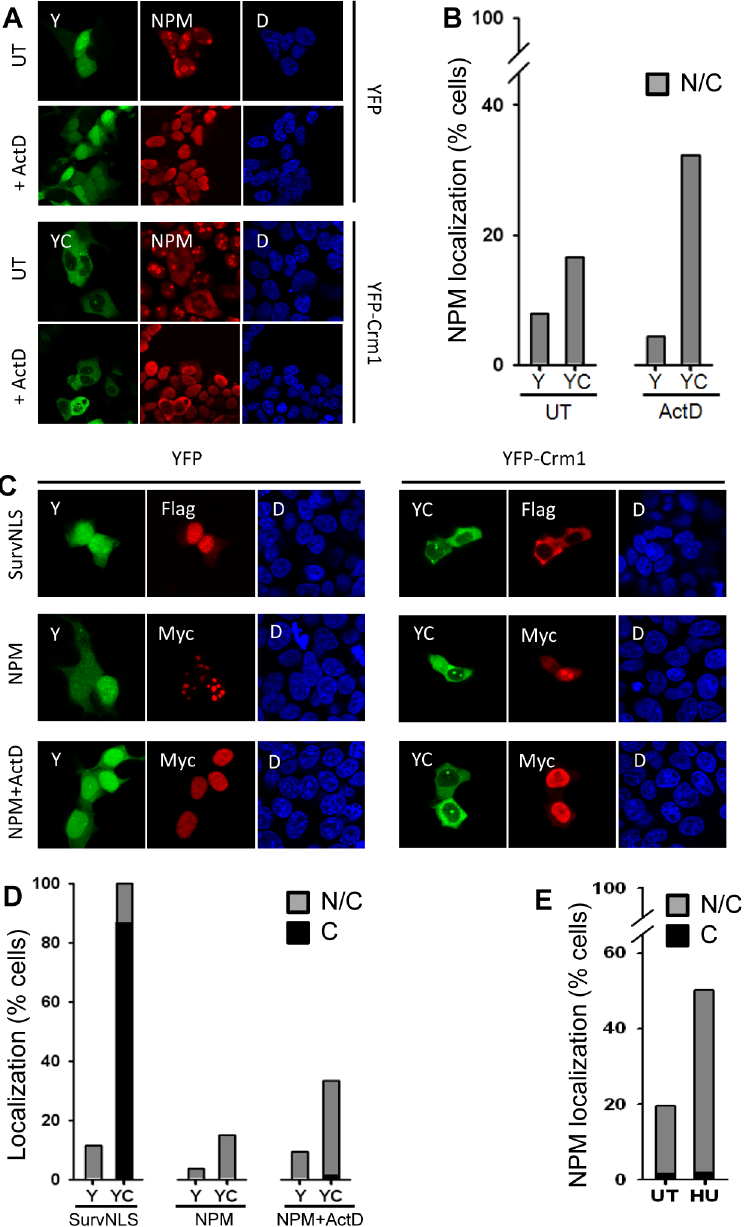
Fig 2. Localization of endogenous and ectopically expressed NPM and effect of treatment with actinomycin D (ActD) and CRM1 overexpression in HEK293T cells. (A) Localization of endogenous NPM in cells overexpressing YFP-CRM1 (or YFP alone) and either untreated (UT) or treated with ActD. Green denotes YFP (Y) or YFP-CRM1 (YC) fluorescence; red, immunostaining of endogenous NPM; and blue, DAPI fluorescence. (B) Percentage of cells showing nuclear and cytoplasmic (N/C) localization of NPM. More than 200 cells were “ blind ” counted. (C) Localization of Flag-SurvNLS and Myc-NPM when co-expressed with YFP alone (control) or YFP-CRM1, and effect of ActD. (D) Quantification of cytoplasmic (C) or nuclear and cytoplasmic (N/C) localization of overexpressed Flag-SurvNLS and Myc-NPM. (E) Effect of treatment with hydroxyurea during 24 h. on the localization of Myc-NPM in cells expressing YFP-CRM1.